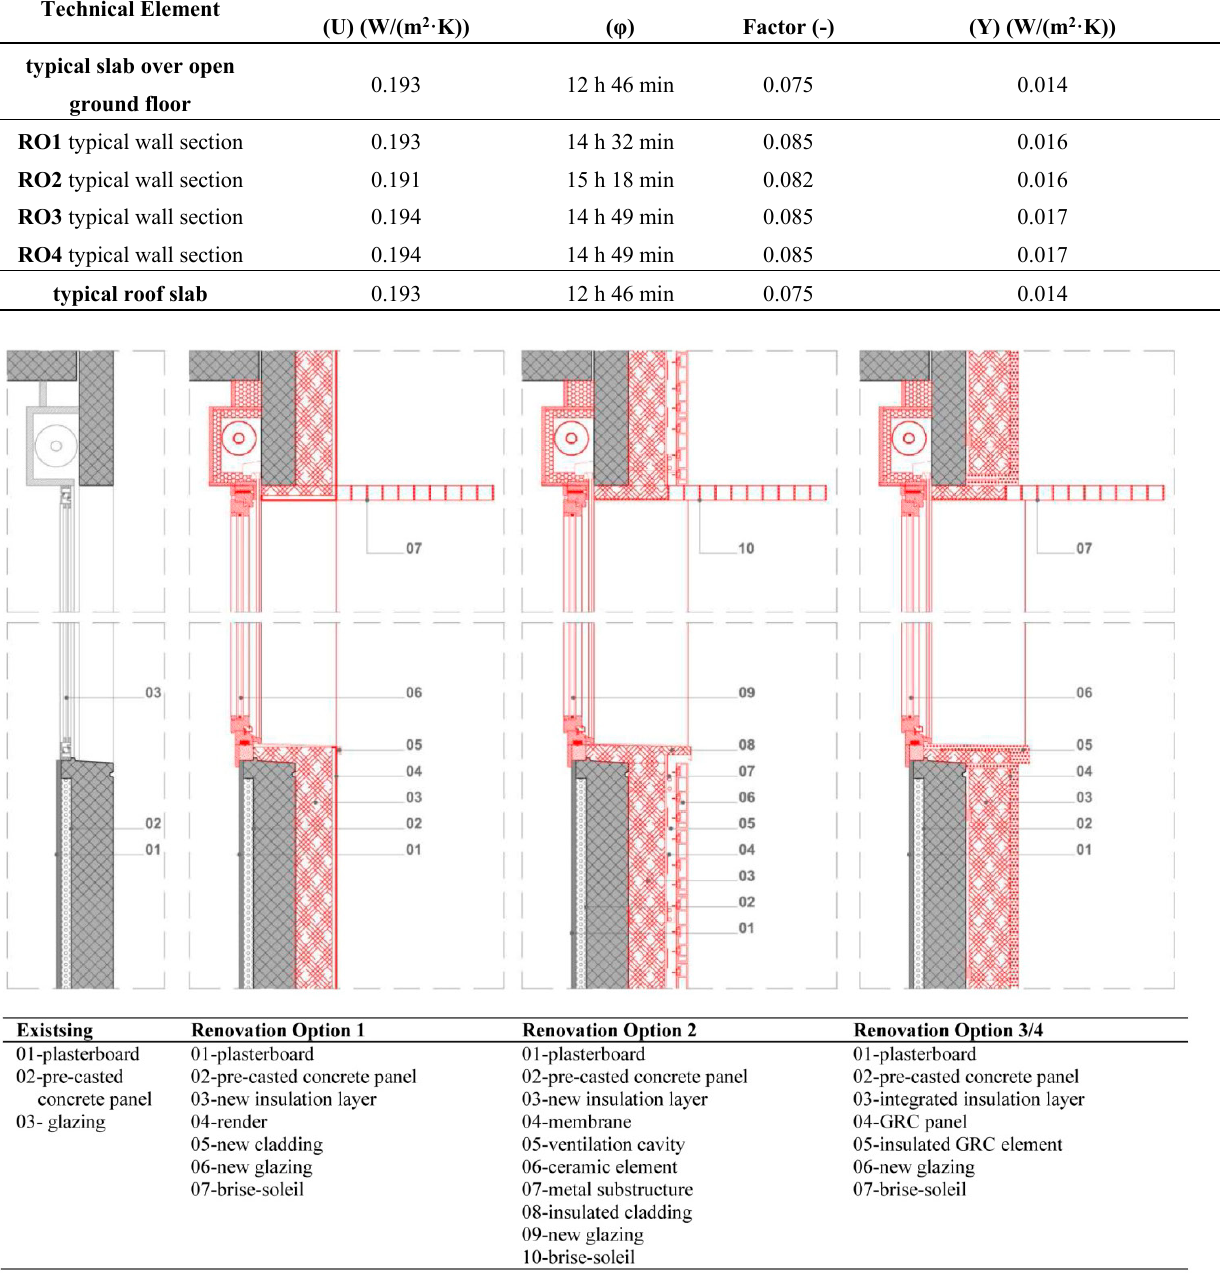
Figure 3. Details of the investigated